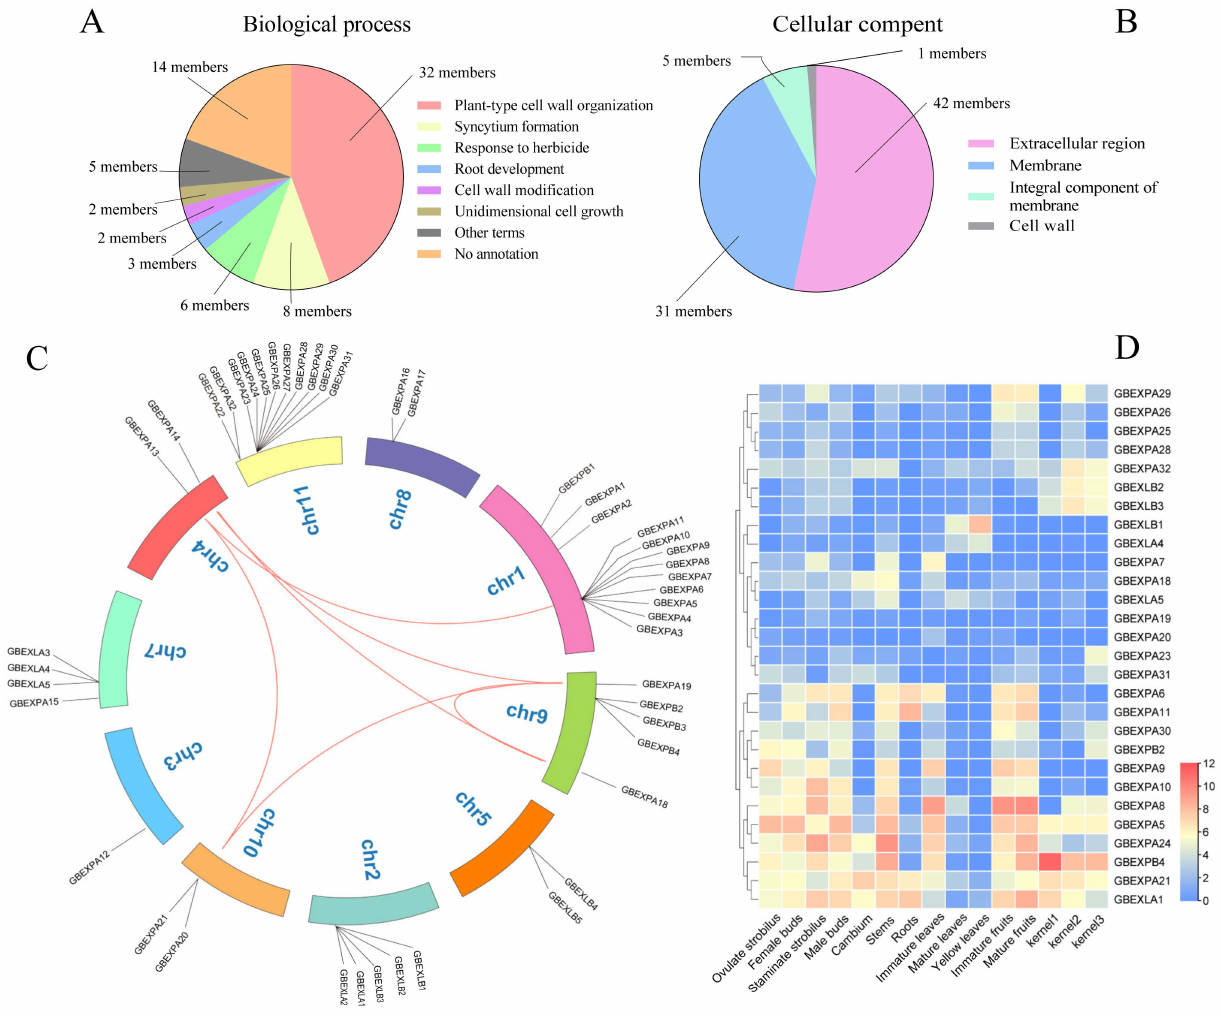
Figure 5. GO annotation, syntenic analysis, and tissue-specific expression of the GbEXP family. ( A ) Biological process terms of GbEXPs . ( B ) Cellular component terms of GbEXPs . ( C ) Collinearity analysis of GbEXPs . ( D ) Tissue-specific expression of GbEXPs in the